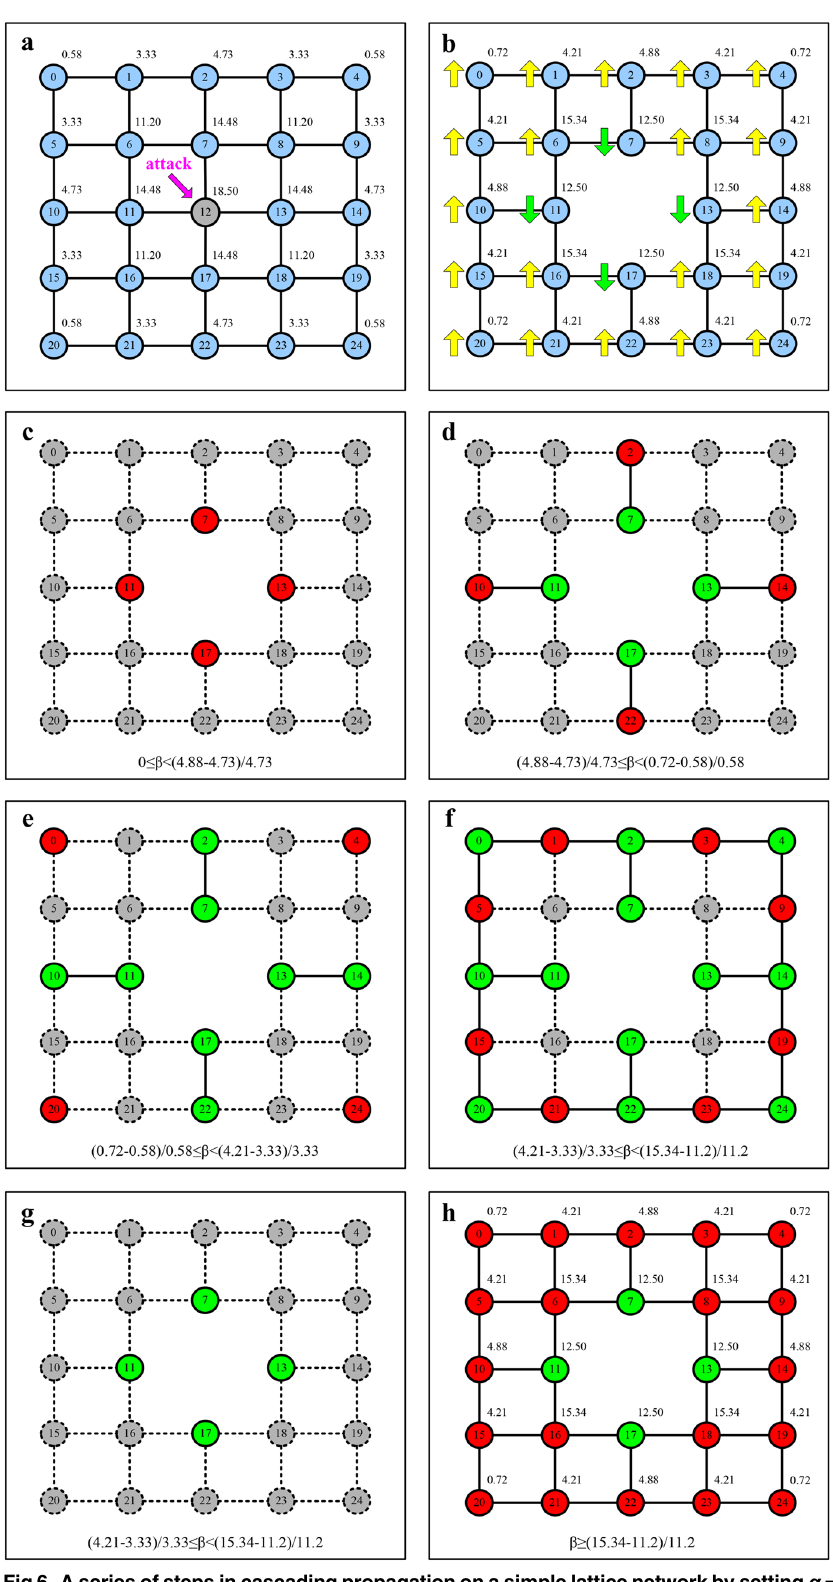
Fig 6. A series of steps in cascading propagation on a simple lattice network by setting α = 1.